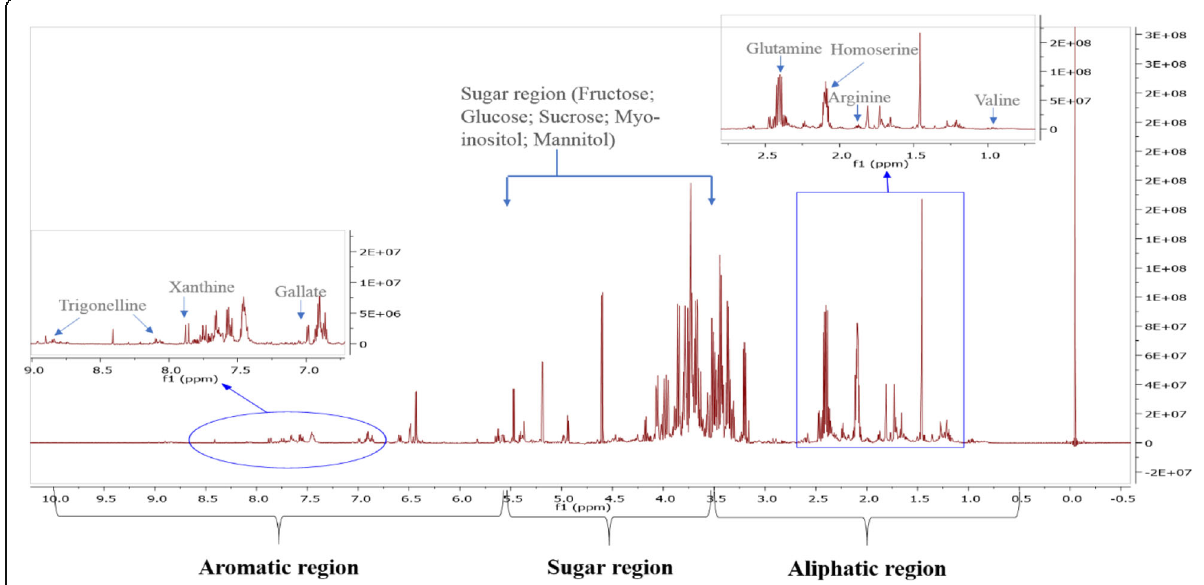
Fig. 2 1 H spectra of the polar extract of Anarrhinum pubescens